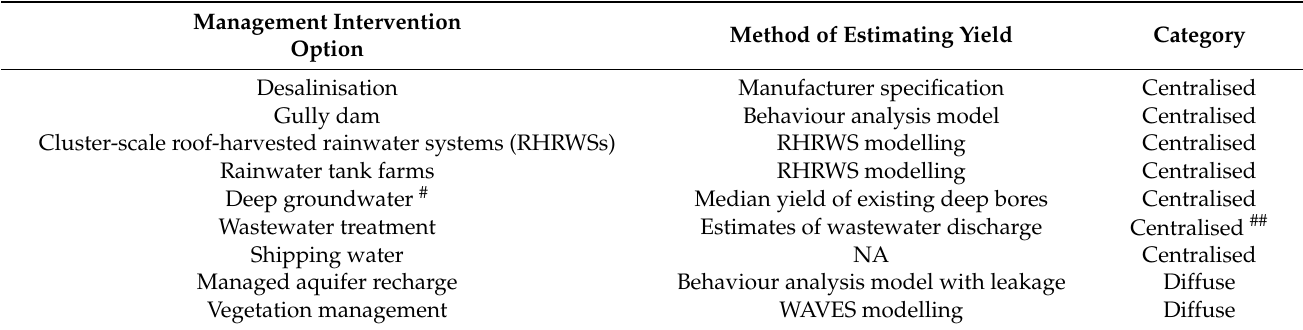
Table 1. Potential management intervention options